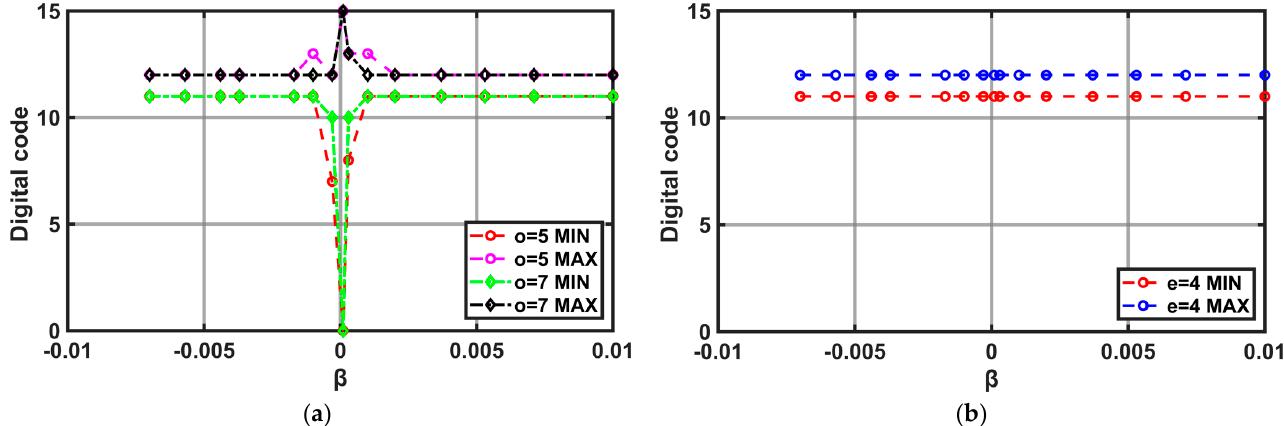
Figure 6. ( a ) Maximum and minimum digital code of the DCC counter when the denominator value of o is 5 and 7. ( b ) Maximum and minimum digital code of the DCC counter when the denominator value of e is 4.